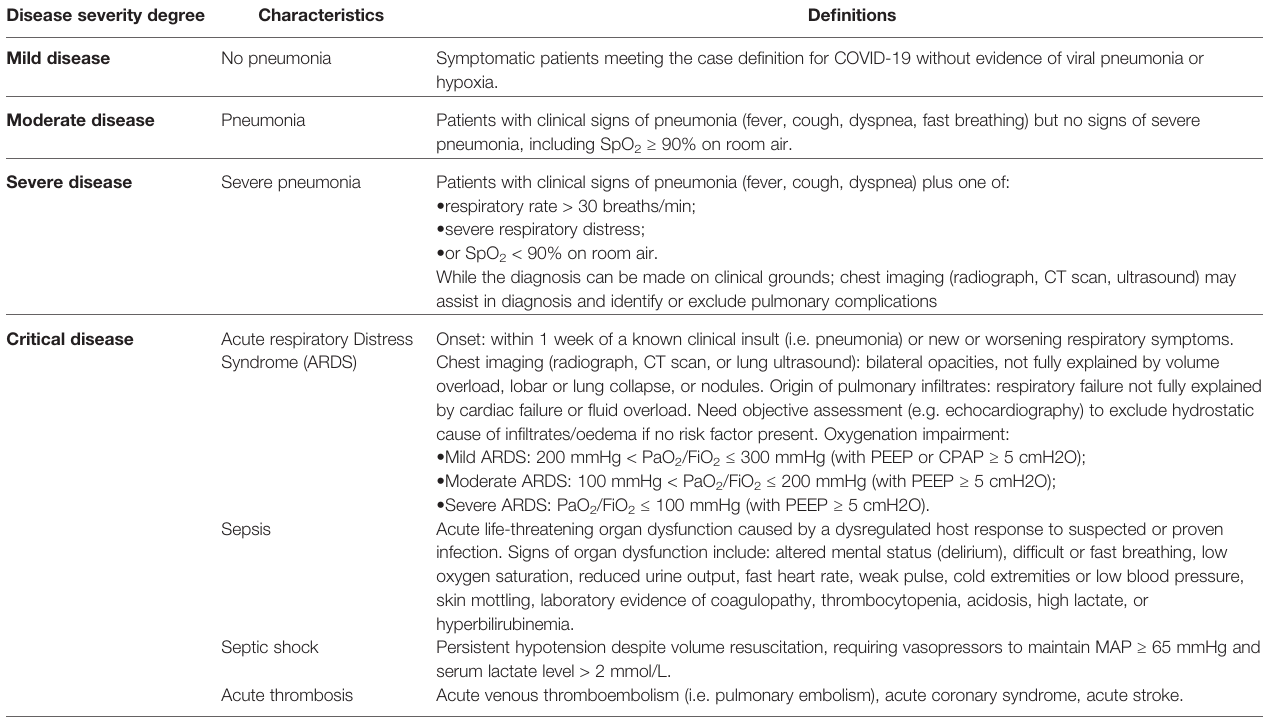
TABLE 1 | WHO COVID-19 disease severity classi fi cation in adults. Disease severity